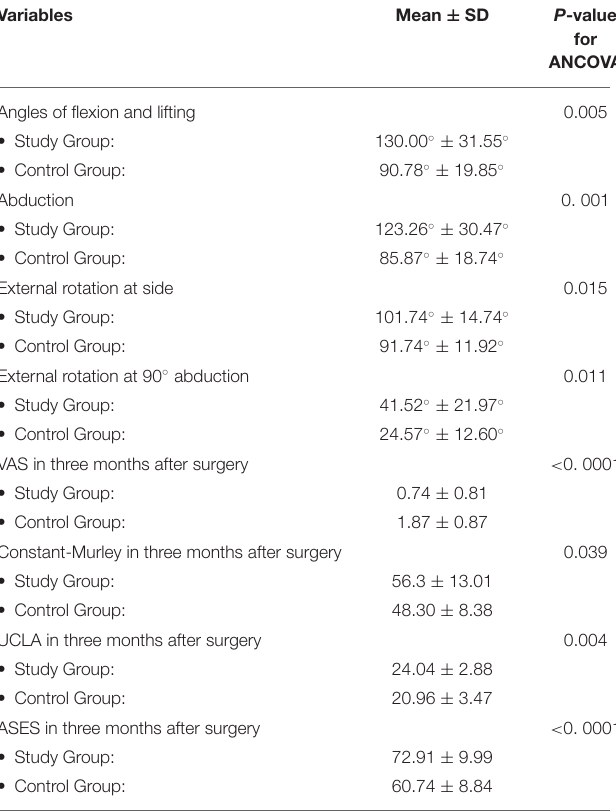
TABLE 2 | The comparisons of clinical outcomes between study and control groups. Variables Mean ± SD P -value